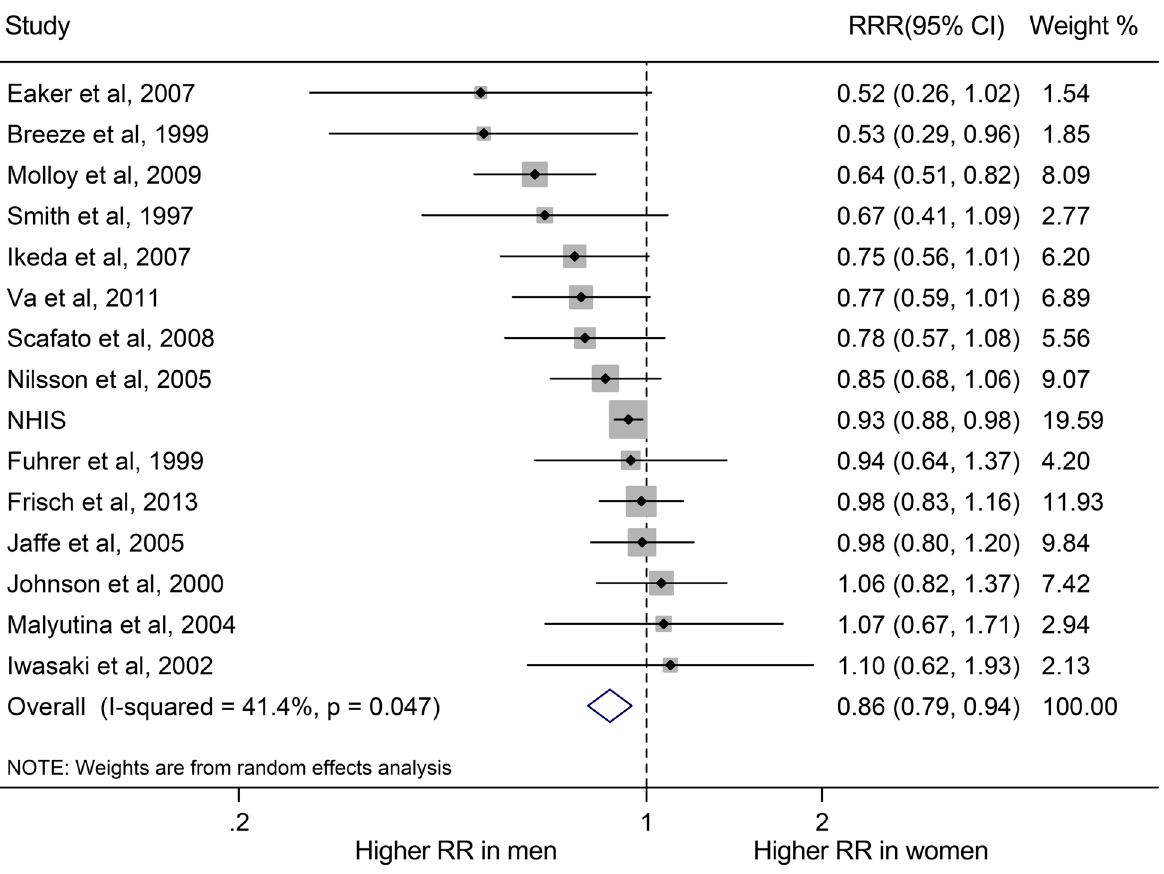
Fig. 3 Women-to-men ratios of relative risks (RRRs) for all-cause mortality comparing non-married to married people. The boxes and lines indicate the RRRs and their 95% confidence intervals (CIs) on a log scale for each study. The pooled odds ratio is represented by a diamond. The size of the gray squares indicate the relative weight of each